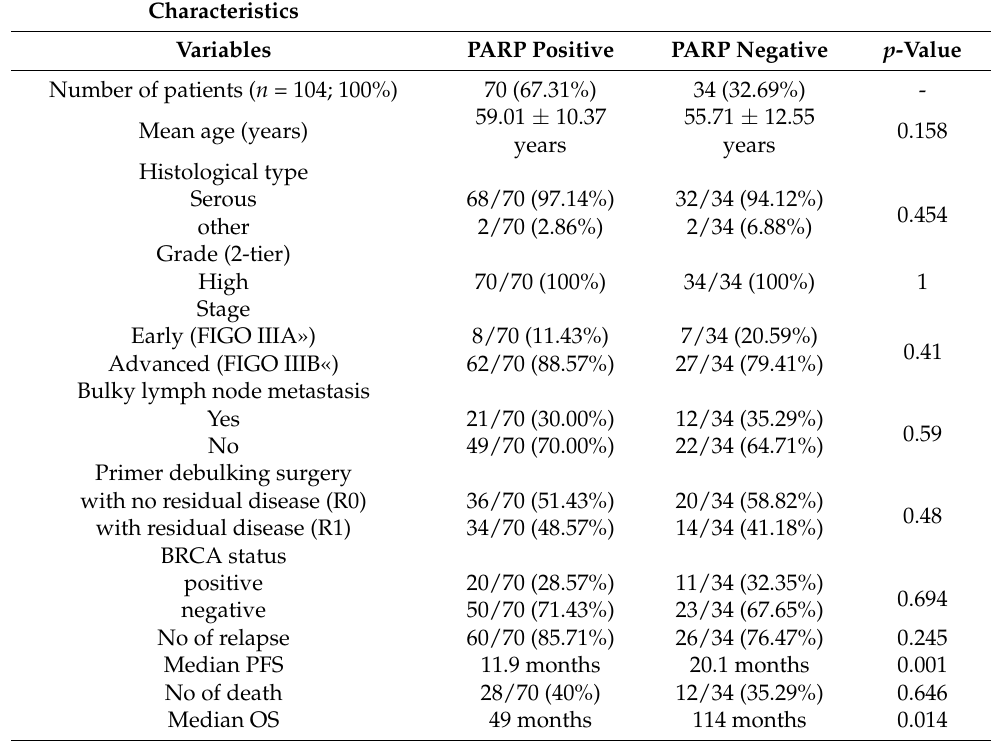
Table 2. Comparison of patient’s characteristics by subgroups.